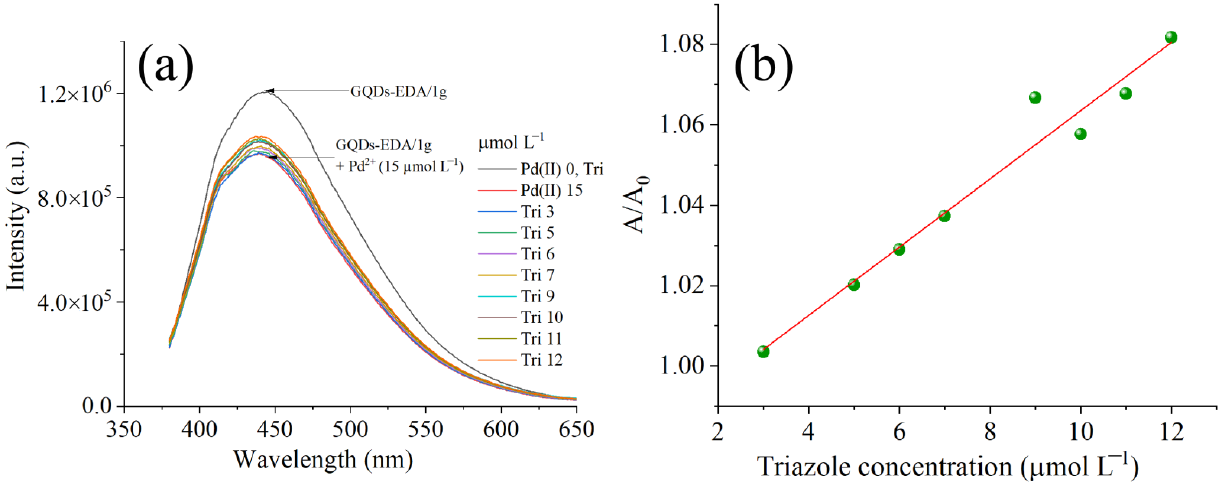
Figure 13. Emission spectra of the GQDs-EDA/1 g and GQDs-EDA/1 g-Pd 2+ system recorded at λ exc = 360 nm in the presence of 3-amino-1,2,4-triazole in the concentration range 0 – 12 µmol L −1 ( a ), and plot which presents an integrated area under emission peak versus concentration of 3-amino-1,2,4-triazole with a linear fitting curve ( b